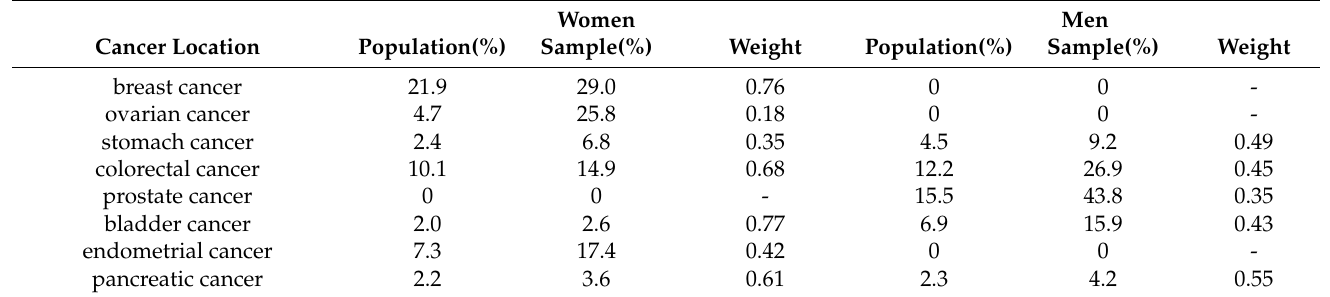
Table 1. Structure of the studied sample, including cancer location in relation to the population.